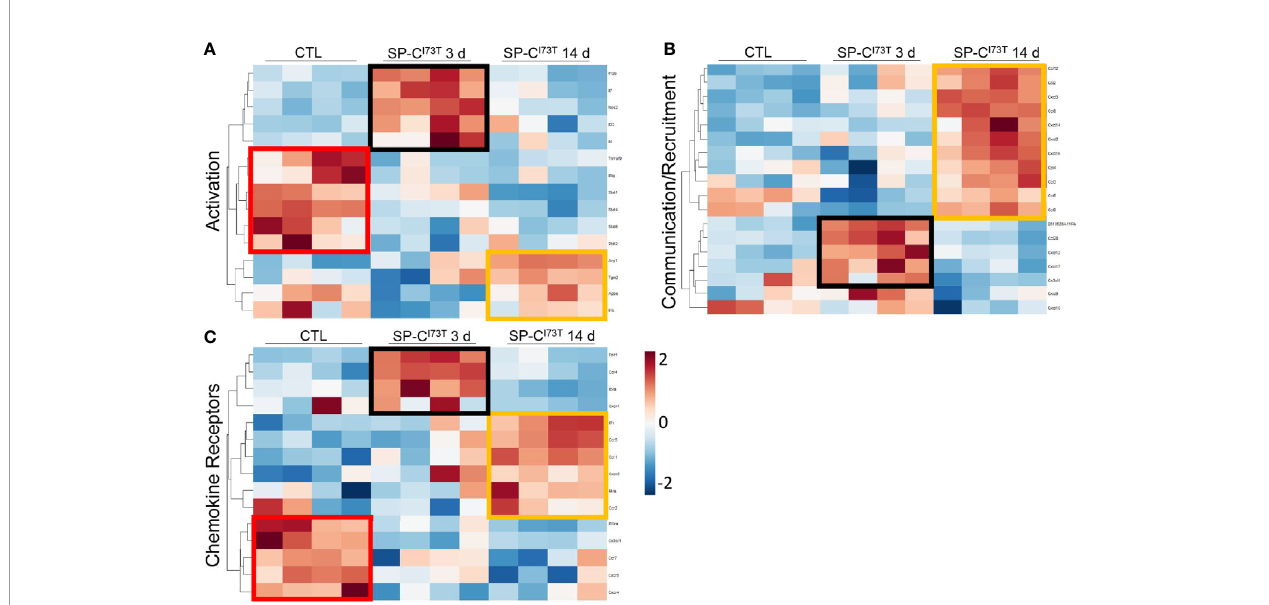
FIGURE 3 | Targeted gene expression analysis of fl ow cytometry sorted CD11b + Ly6C hi monocytes following SP-C I73T induced injury. (A-C) Differential gene expression of factors associated with (A) activation, (B) cell communication/recruitment, or (C) chemokine receptor. Heat maps show signi fi cant genes. Gene selection was based on previous literature (9, 42, 43). Criteria for signi fi cance were set at fold change > 1.5 and false discovery rate (q-value) < 0.05. N = 4 was utilized in each study condition. Note red boxes represent genes uniquely expressed in control populations; black boxes represent genes uniquely expressed 3 d after SP-C I73T injury; orange boxes represent genes uniquely expressed 14 d after SP-C I73T